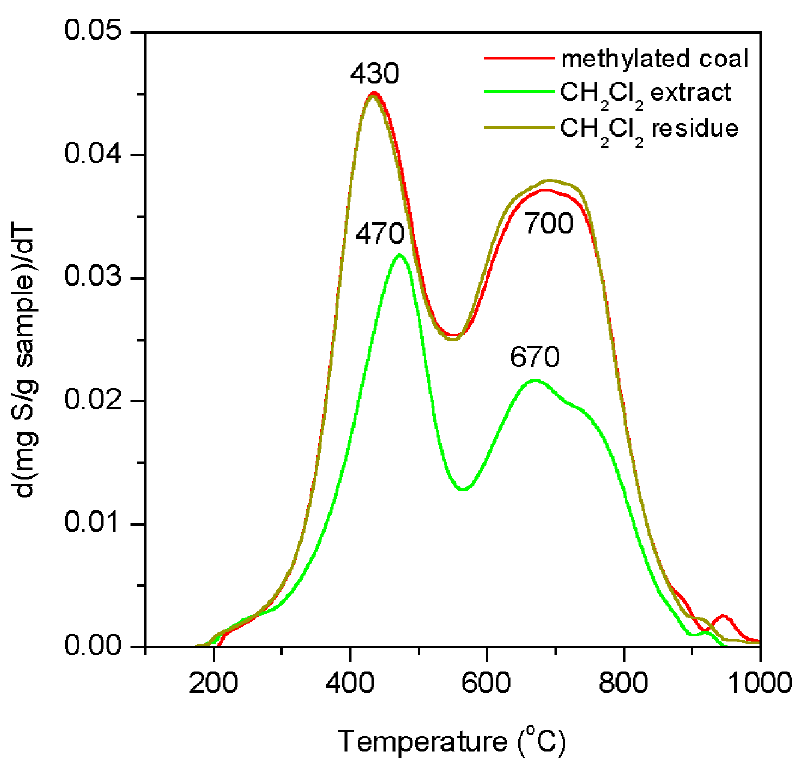
Fig. 8 AP-TPR kinetograms of Illinois No. 6 coal methylated in K/NH 3 system and products of its